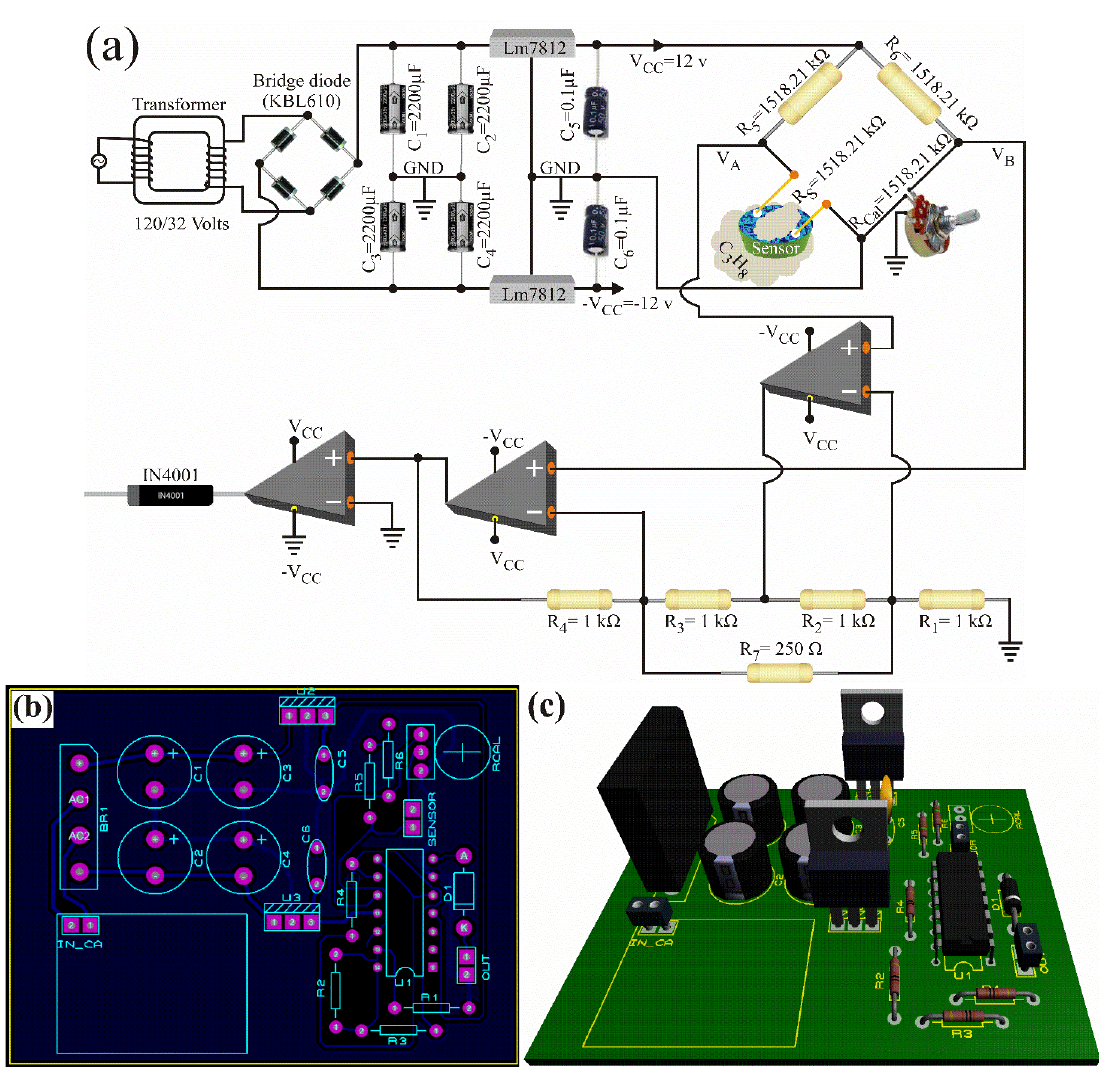
Figure 7. Propane gas detector: ( a ) electronic diagram, ( b ) printed circuit and electronic components’ distribution, and ( c ) 3D view.